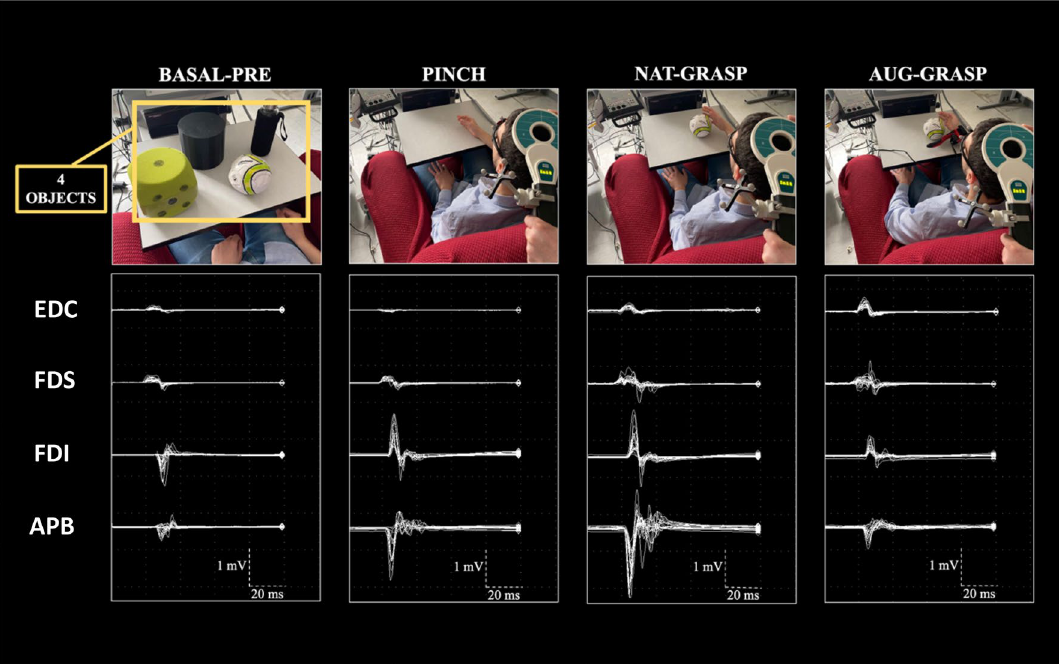
Figure 2. Experimental conditions. MEPs were simultaneously recorded from Extensor Digitorum Communis (EDC), Flexor Digitorum Superficialis (FDS), Abductor Pollicis Brevis (APB) and First Dorsal Interosseous (FDI) muscles during resting condition (BASAL-PRE), imagery of a pinch-grip (PINCH) between the thumb and index finger, imagery of a natural grasping (NAT-GRASP) or augmented grasping (AUG-GRASP). MEPs recorded during Basal-post condition are not shown. [Original photographs of the experimental setup taken by Simone